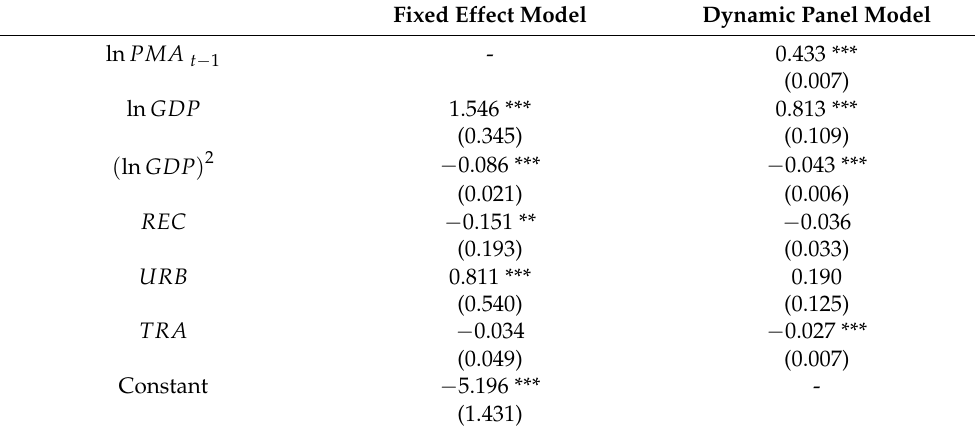
Table 2. Estimation Results for Particulate Matter 2.5 Average Exposure